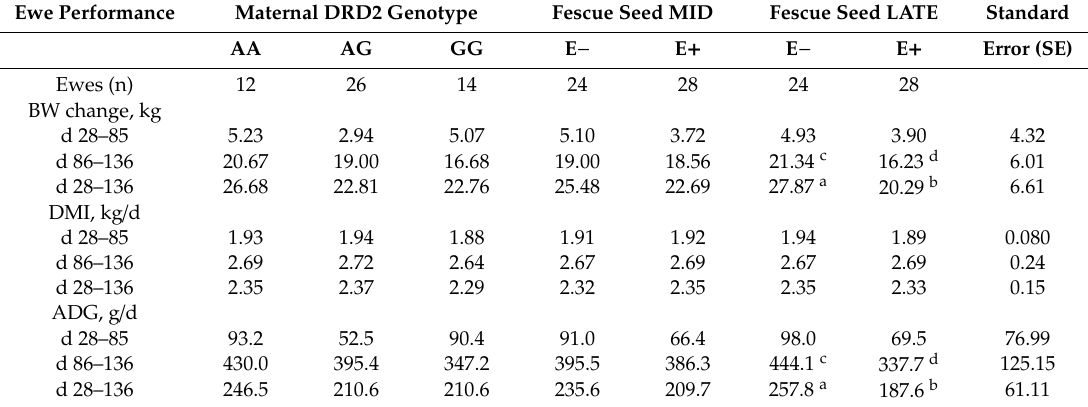
Table 1. Body weight change (BW), dry matter intake (DMI) and average daily gain (ADG) for ewes of different genotypes (DRD2 SNP) fed E− or E+ seed.